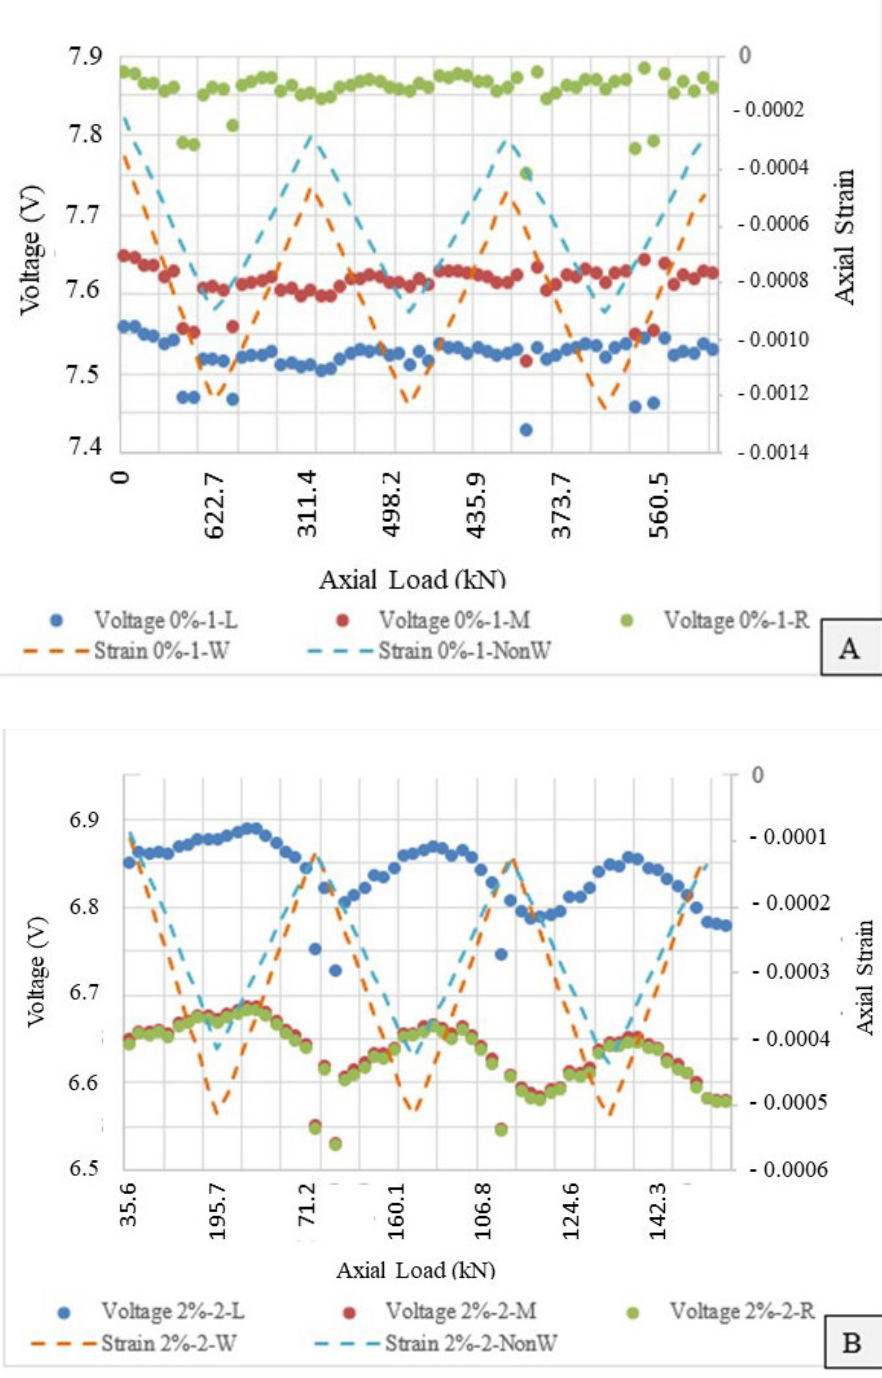
Figure 5. Stress–Strain Curves Showing Multiple Loading Cycles: 0% ( A ) and 2% ( B ) for both Test 1 and Test 2.